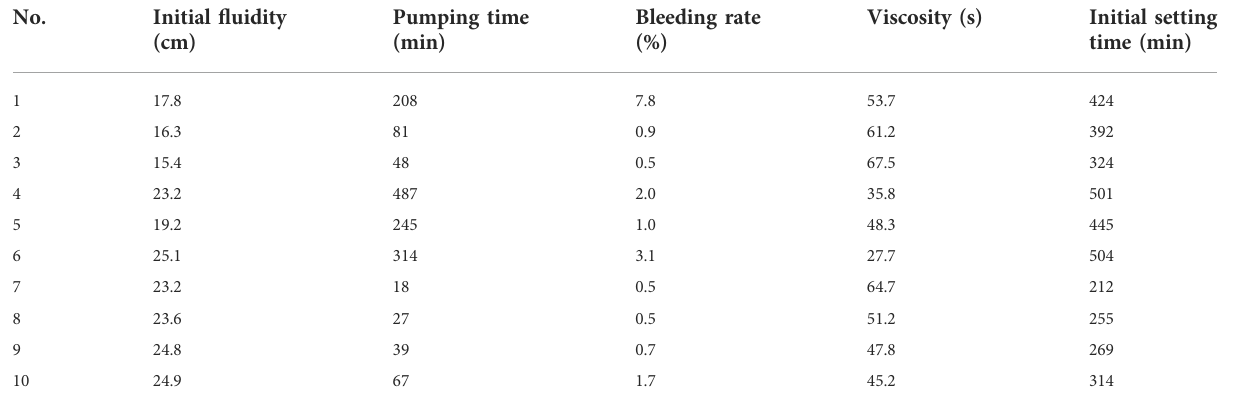
TABLE 3 The properties of grouts with different composition.